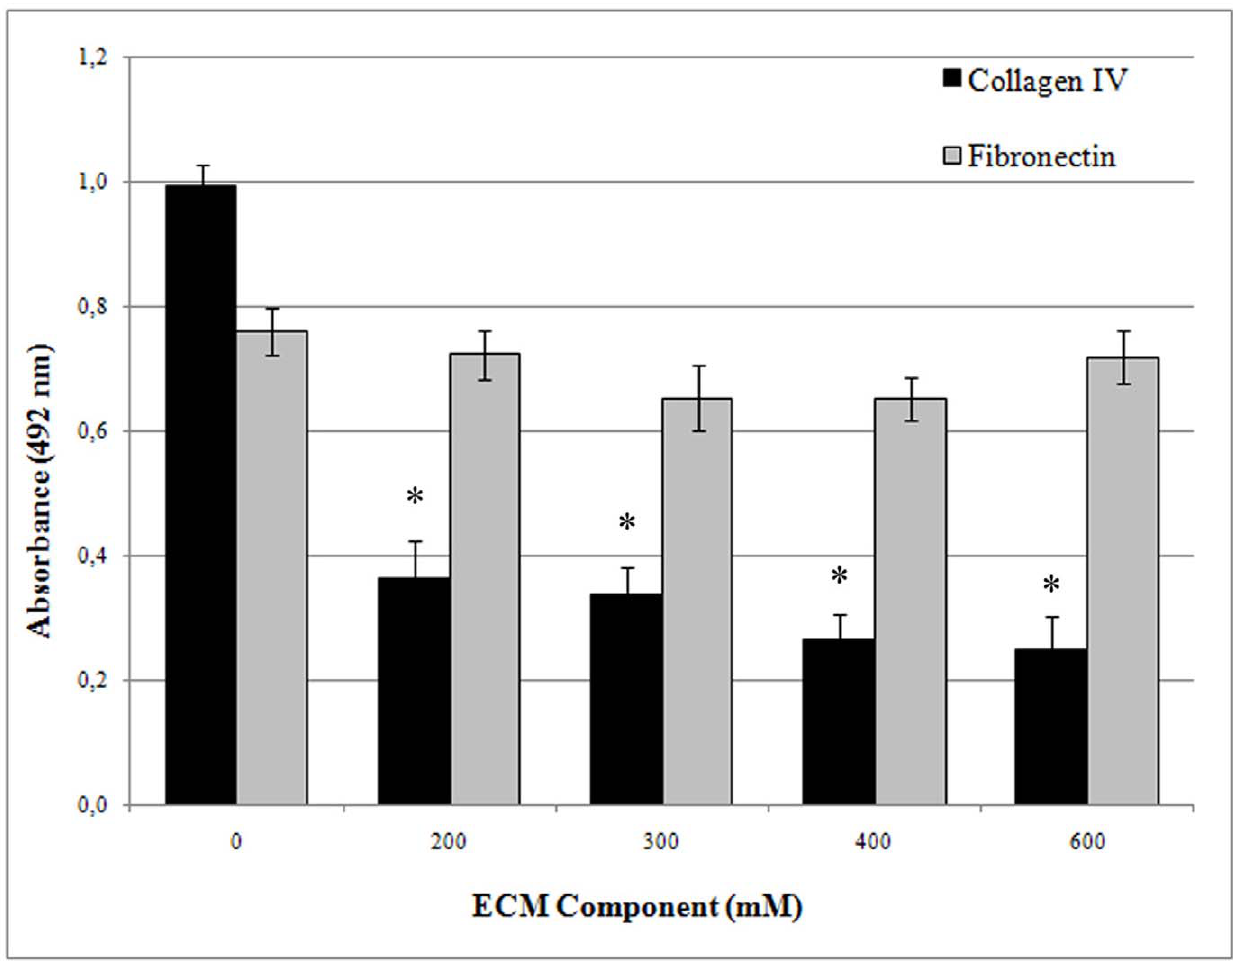
Figure 7. Effect of extracellular matrix macromolecules on PLG binding by LipL32. Binding of LipL32 (10 m g/ml) to immobilized PLG (10 m g/ml) was performed with the addition of increasing concentrations of plasma fibronectin or collagen type IV (0 to 600 mM). The detection of bound-PLG was assayed by specific antibodies. Bars represent the mean absorbance values 6 the standard deviation of four replicates for each condition and are representative of two independent experiments. Results of statistically significant interference with binding in comparison with the positive control (no addition of purified ECM macromolecules) are shown: P , 0.0003 (*).